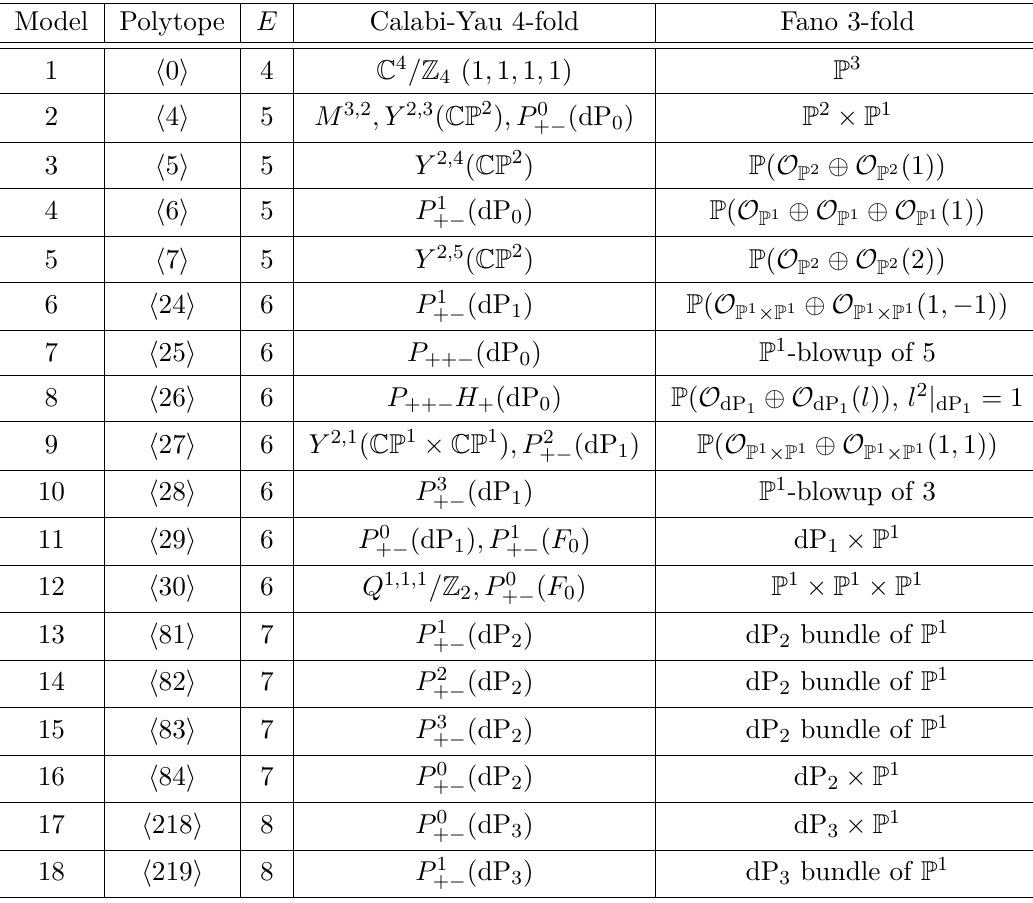
Table 2 . The names of smooth Fano 3-folds and toric Calabi-Yau 4-folds corresponding to the 18 regular reflexive polytopes in dimension 3. E is the number of external points of the reflexive